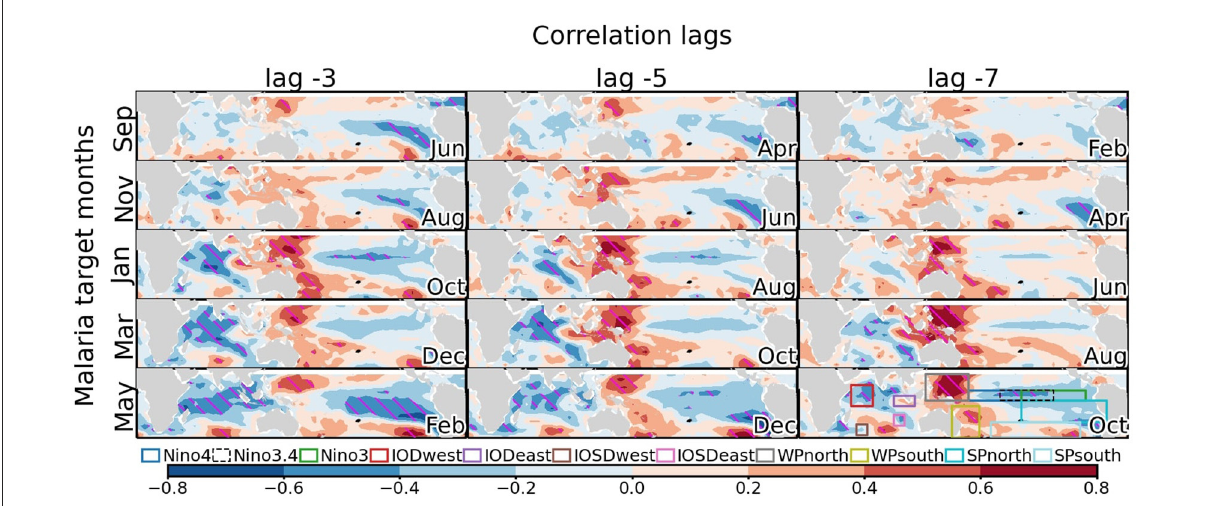
FIGURE3 Sea surface temperature precursors of malaria in South Africa. Lag-regression maps of SST on malaria incidence in South Africa (Vhembe district in Limpopo province) are shown in function of target malaria month (rows) and lag (columns). The month when the precursors are observed is indicated in the bottom-right corner of each panel. For example, lag − 3 precursors of observed malaria incidence in January are observed in October. Correlation is shaded at an interval of 0.2 with blue and red shadings for negative and positive correlations, respectively. Correlations that are significant at the 5% significance level are hatched in magenta. The conditions illustrated are associated with high malaria incidence. See Supplementary Figure 1 for the location of Limpopo. The sectors used later to construct SST-based climate indices are illustrated in the bottom-right panel according to the legend.